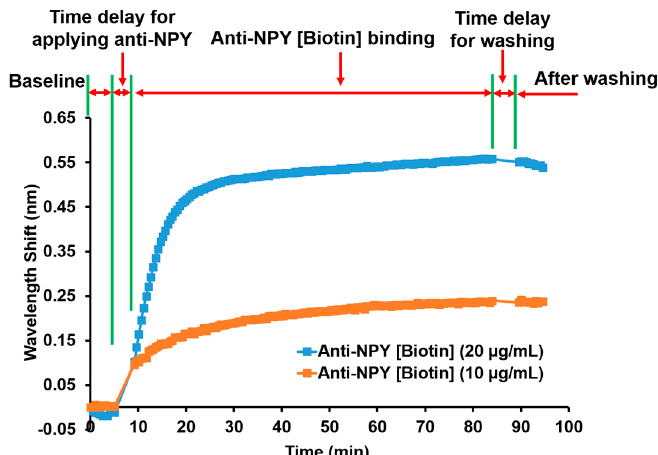
Figure 4. Wavelength shift and process steps as a function of time for anti-NPY [Biotin] binding to Avidin-D. The curves represent triplicate (n = 3) averages.